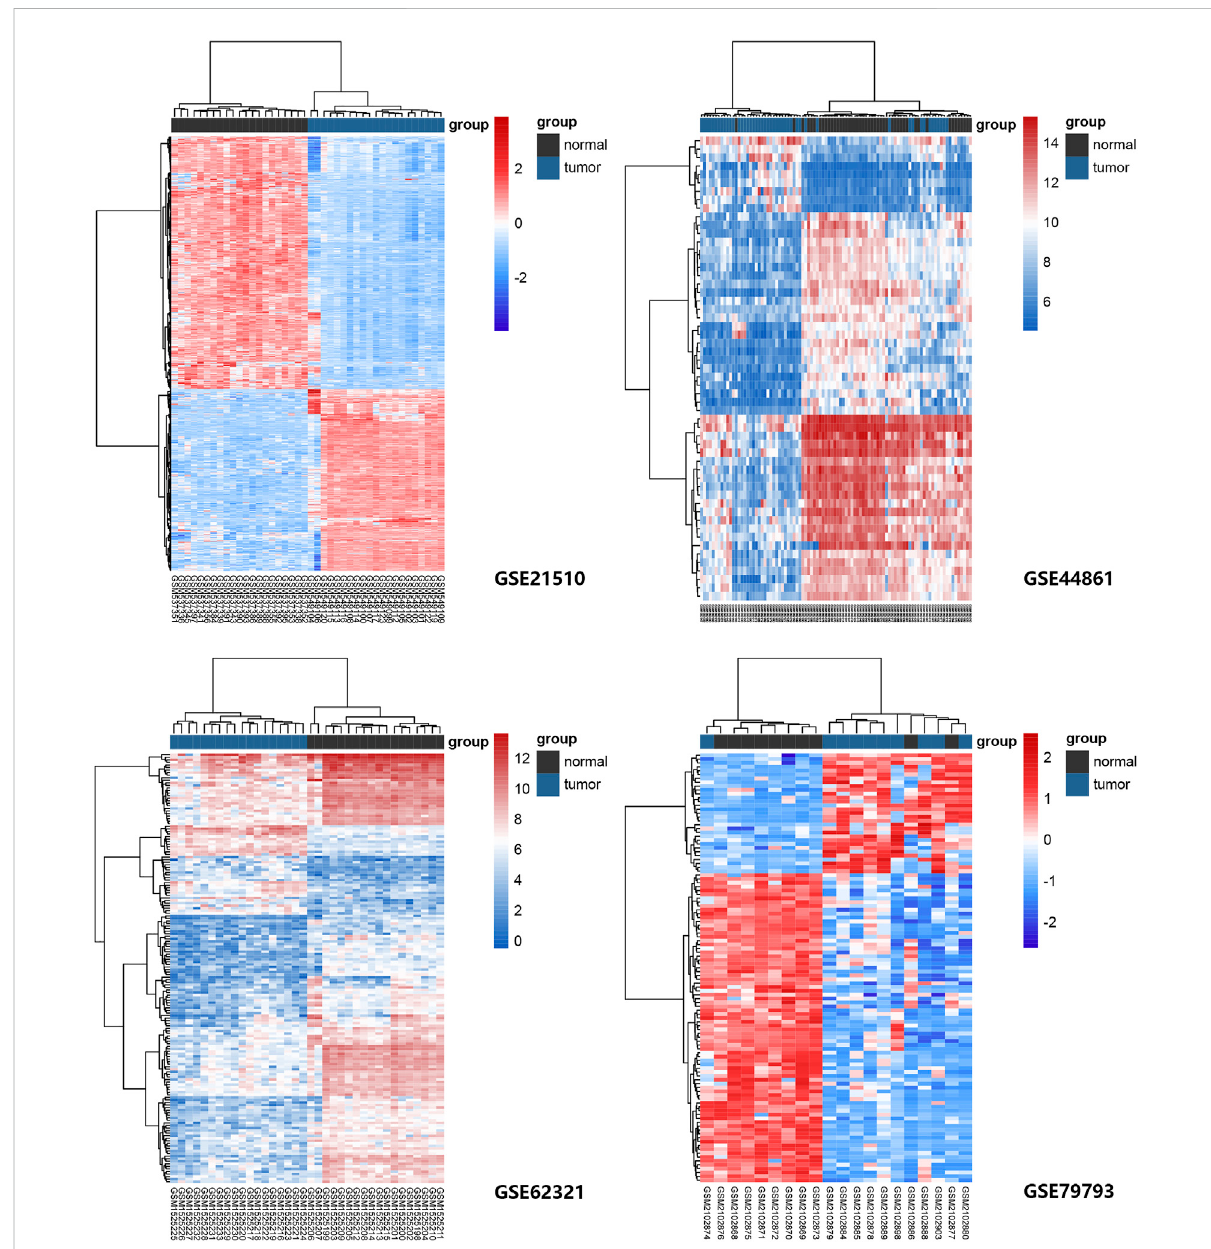
FIGURE 1 Heat maps of ferroptosis-related gene expression in normal and tumor samples in GEO: GSE21510, GSE44861, GSE62321, and GSE79793 datasets. The genes were clustered according to their expression levels. The red color represents high expression and the blue color represents low